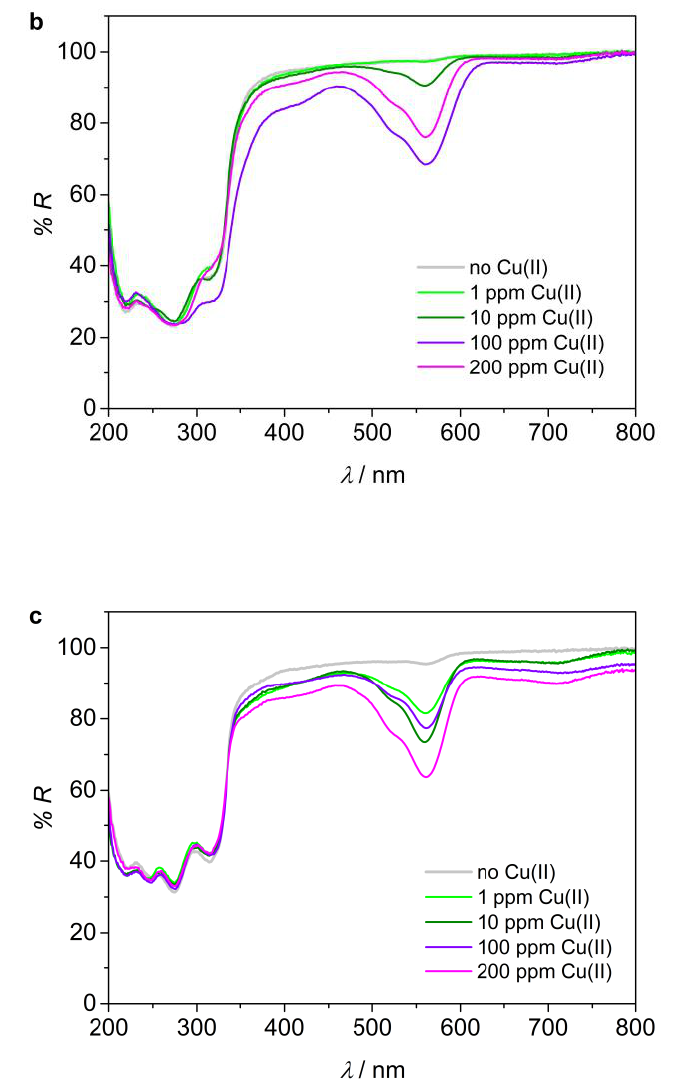
Figure 7. Reflectance spectra of the RBH loaded polymeric materials, prior and after 1 night immersion in CuCl 2 water solutions (pH = 7) at different Cu(II) concentrations: ( a ) porous membrane, ( b ) fibers from DMF, and ( c ) fibers from DCM/acetone.